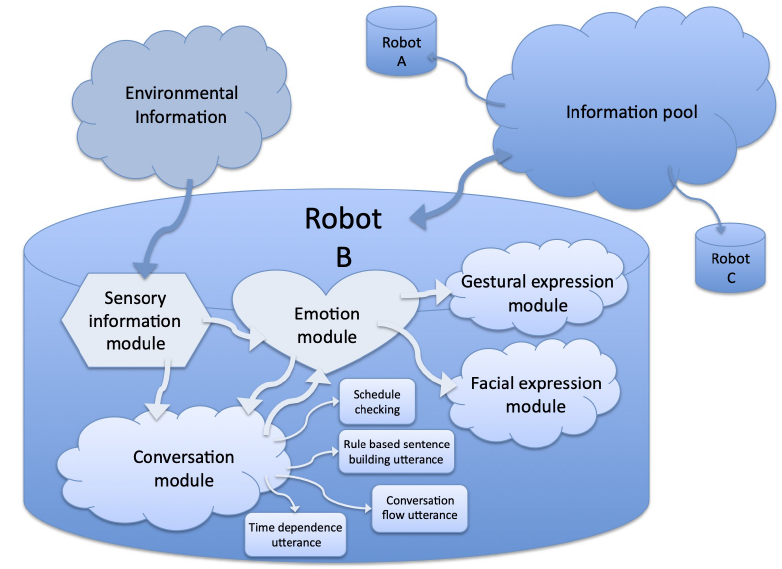
Figure 13. Overview of robot